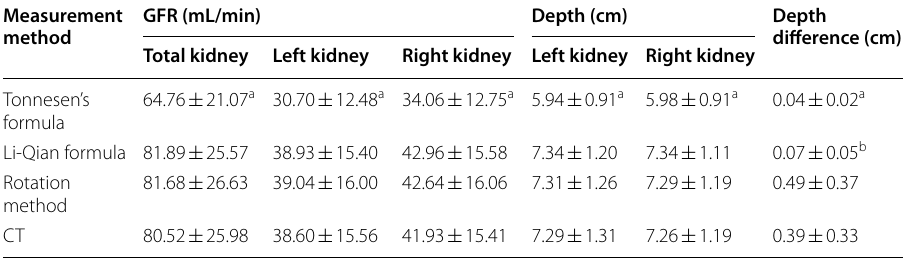
a : P < 0.001, Tonnesen’s formula vs CT; b : P < 0.001, Li Qian’s formula vs